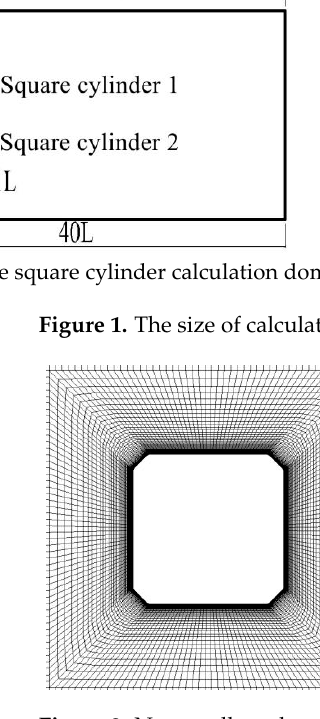
Figure 2. Near-wall mesh generation.